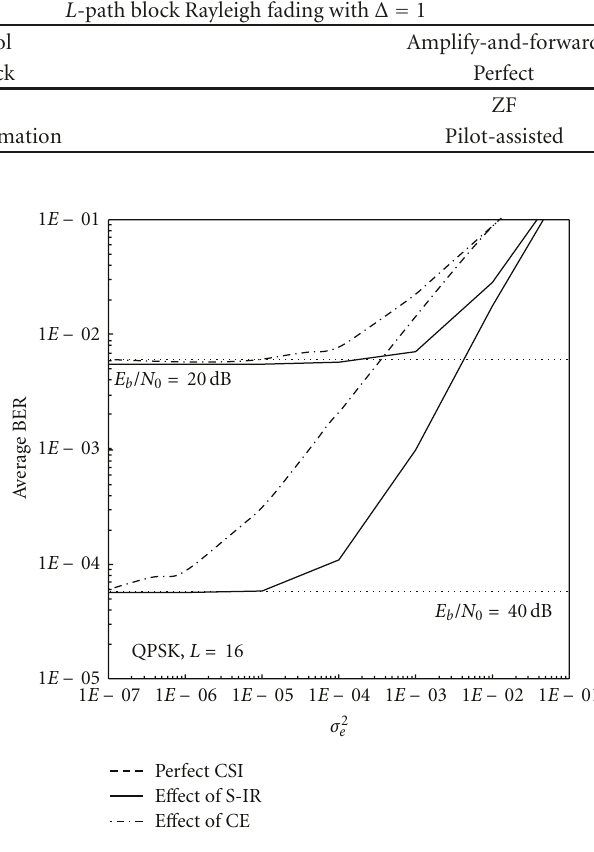
Figure 7: E ff ect of channel estimation error σ 2